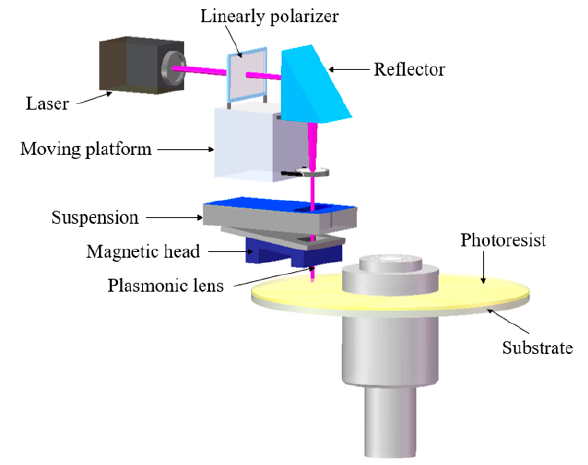
Figure 1. Schematic configuration of the rotational near-field photolithography.